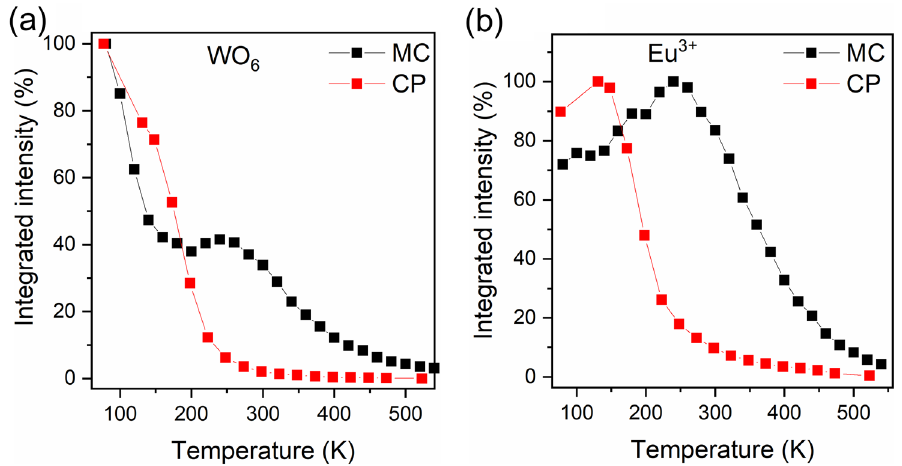
Figure 6. Integrated emission intensity of WO 6 groups ( a ) and Eu 3+ ions ( b ) of BMW: 0.1% Eu 3+ samples prepared by MC and CP